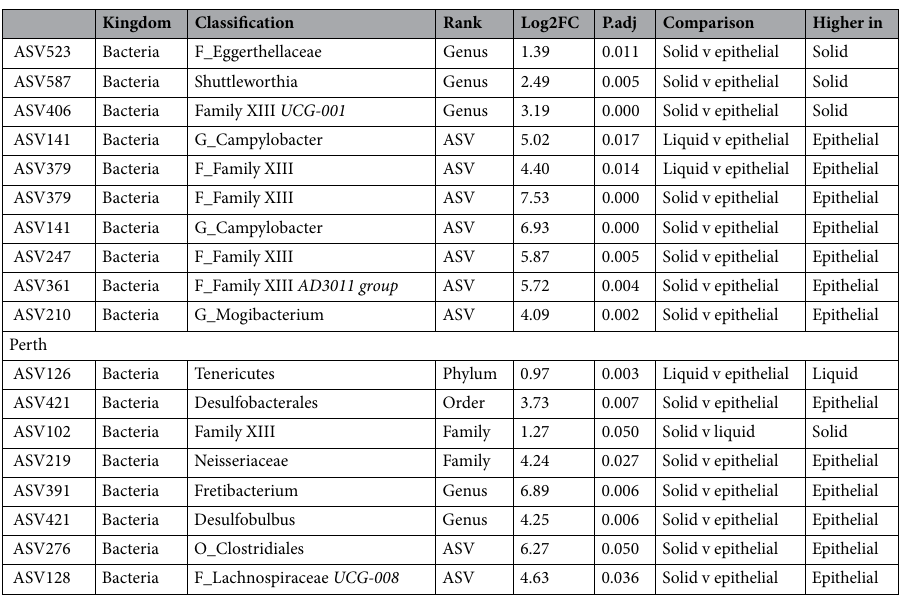
Table 9. Differential abundance analysis investigating the pairwise differences in bacterial and archaeal abundances between each of the fractions (i.e. solid, liquid and epithelial) in the Cheviot, Lanark and Perth breeds. Analysis was conducted across all taxonomic ranks for bacterial populations (Phylum, Class, Order, Family, Genus and ASV), and lower taxonomic ranks for archaeal populations (Genus and ASV) using the Wald’s pairwise test from DESeq2. Table reports significant findings along with the log10 of normalised counts (Mean ± Sd), BH adjusted P values, Log2 fold change, taxonomic rank and classification, fractions compared, and the fraction the abundance was increased in. Cheviot (solid n = 7, liquid n = 7, epithelial n = 7), Lanark (solid n = 5, liquid n = 5, epithelial n = 5), Perth (solid n = 5, liquid n = 5, epithelial n =